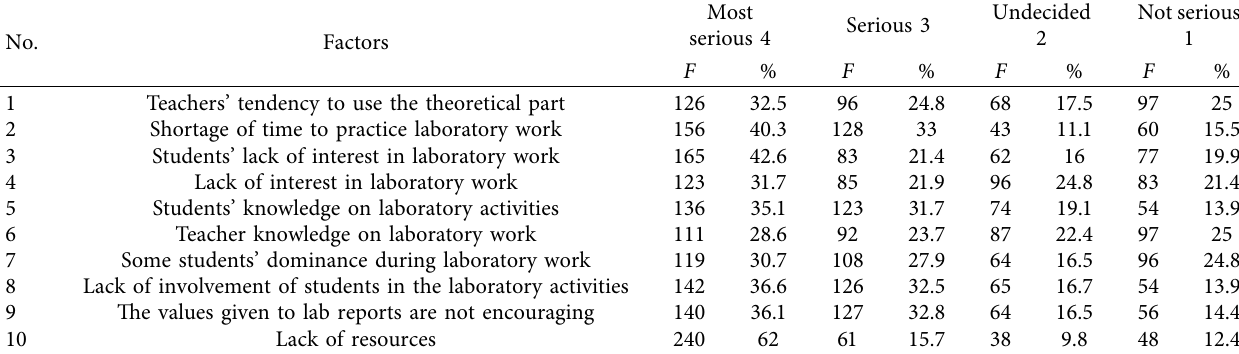
Table 8: Students’ response on factors affecting the implementation of laboratory work.